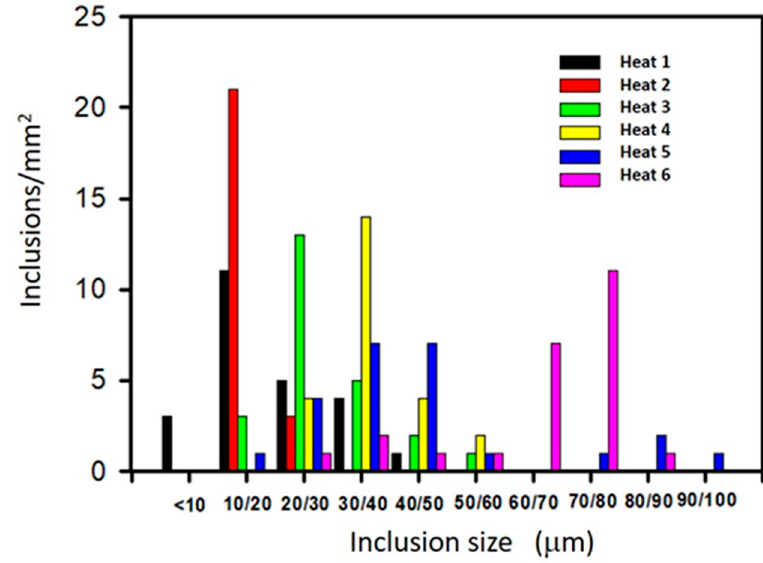
Figure 9. Inclusion size distribution. Table 2. Inclusion maximum length L max ( µ m) for analyzed plans in each